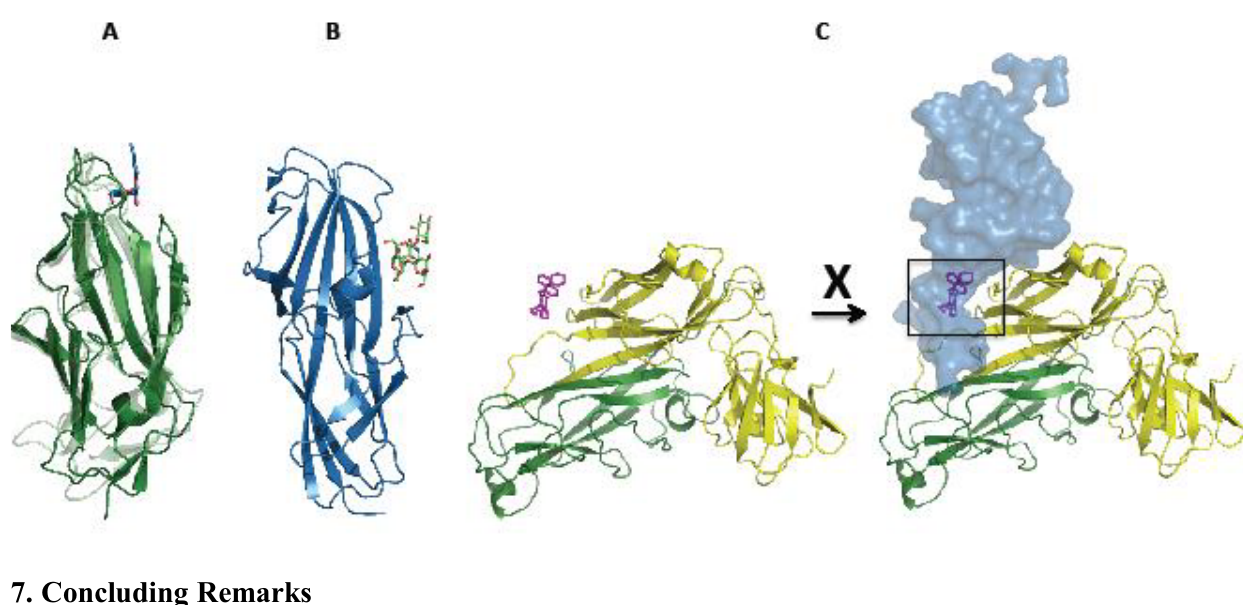
Figure 4. Adhesin and pilicide binding sites. (A) FimH binds a mannose moiety via a L distal pocket. In so doing, the pocket tightens around it. Pre-mannose binding FimH is L in dark green and mannose coloured light green (PDB 3JWN [78]), mannose-bound FimH L in blue (PDB 1UWF) [99]. The mannose binding event also leads to structural changes at , the region in contact with FimH [78]. (B) PapG adhesin the opposite end of FimH L P displays side-on binding of the globoside. The PapG lectin domain is coloured in blue and the GbO globoside in green (PDB 1J8R) [75]. (C) Current pilicide design targets a 4 hydrophobic chaperone patch, which would normally bind to the usher NTD, so preventing bound to (cid:87)(cid:75)(cid:72)(cid:3) (cid:83)(cid:76)(cid:79)(cid:76)(cid:70)(cid:76)(cid:71)(cid:72)(cid:3) (cid:181)(cid:21)(cid:38)(cid:182)(cid:3) the interaction with the usher. The structure of PapD:PapG L (coloured in yellow, green and magenta, respectively, PDB 2XG4) is incompatible with concurrent binding to the usher NTD (blue surface, FimD taken in homology to PapC by alignment with PDB 1ZE3 [100]), due to clashing of pilicide and usher, as has been verified experimentally